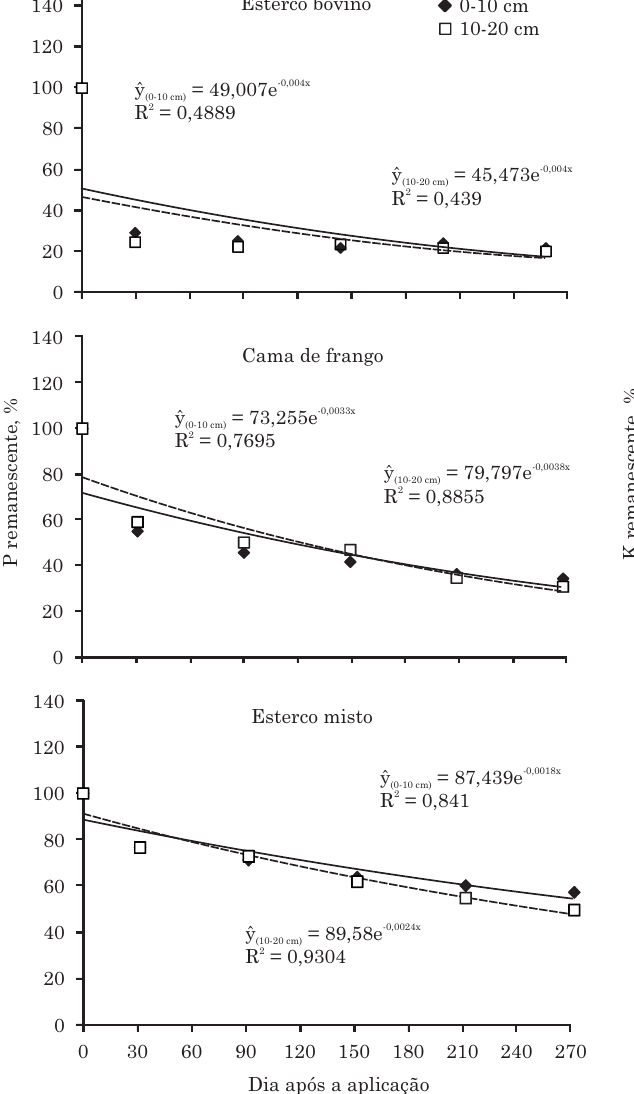
Figura 5. Percentual remanescente de potássio em amostras de esterco bovino, cama de frango e esterco misto, nas camadas de 0-10 e 10-20 cm, em função dos períodos de